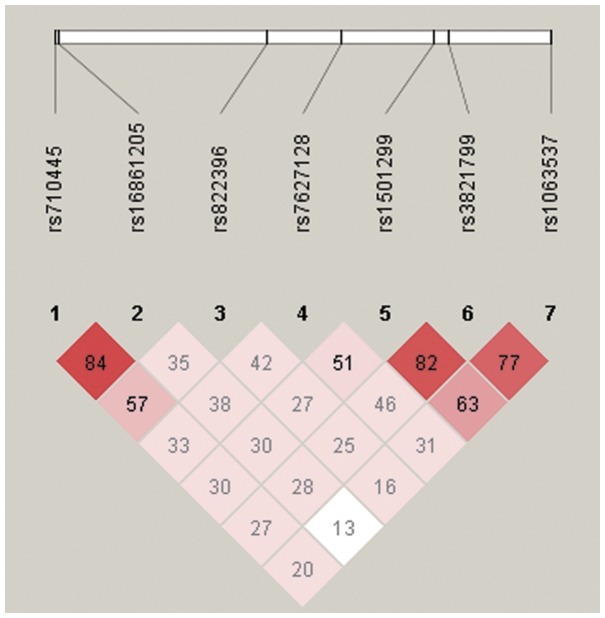
Linkage disequilibrium (LD) plots for ADIPOQ.The LD plots were generated by Haploview 4.2. Polymorphisms are identified by their dbSNP rs numbers, and their relative positions are marked by vertical lines within the white horizontal bar. The numbers within squares indicate the D’ value, expressed as a percentile.